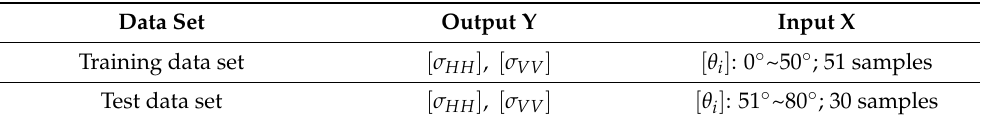
Table 1. Data set of the 3D sea surface backscattering coefficients changing with the incident angle. Data Set Output Y Training data